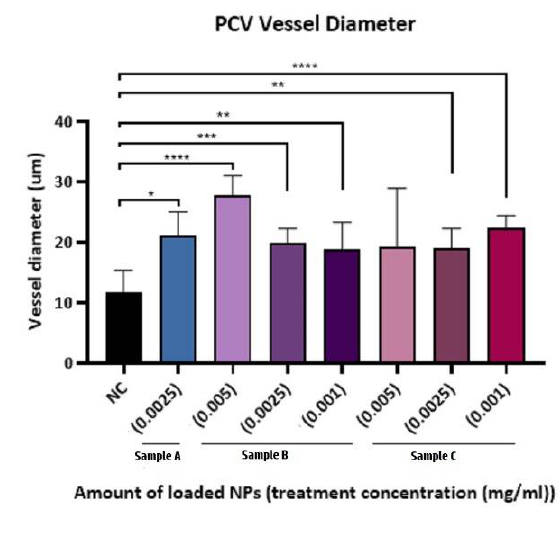
Figure 6. Cardiac function assessment of loaded PLGA-PEG-PLGA NPs. ( A ) Heartbeats of groups treated with sample A NPs (0.005 and 0.0025 mg/mL), sample B NPs (0.005, 0.0025, and 0.001 mg/mL), and sample C NPs (0.0025 and 0.001 mg/mL) were significantly reduced compared to (NC)